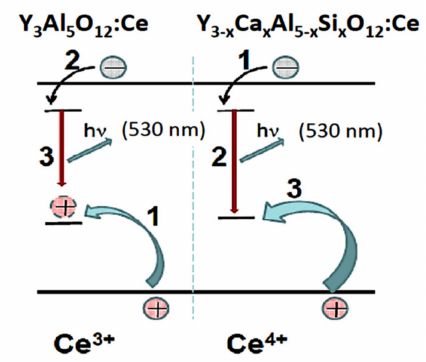
Figure 13. The difference in the mechanism of excitation of Ce 3+ and Ce 4+ luminescence in YAG: Ce and Y 3 − x Ca x Al 5 − y Si y O 12 :Ce